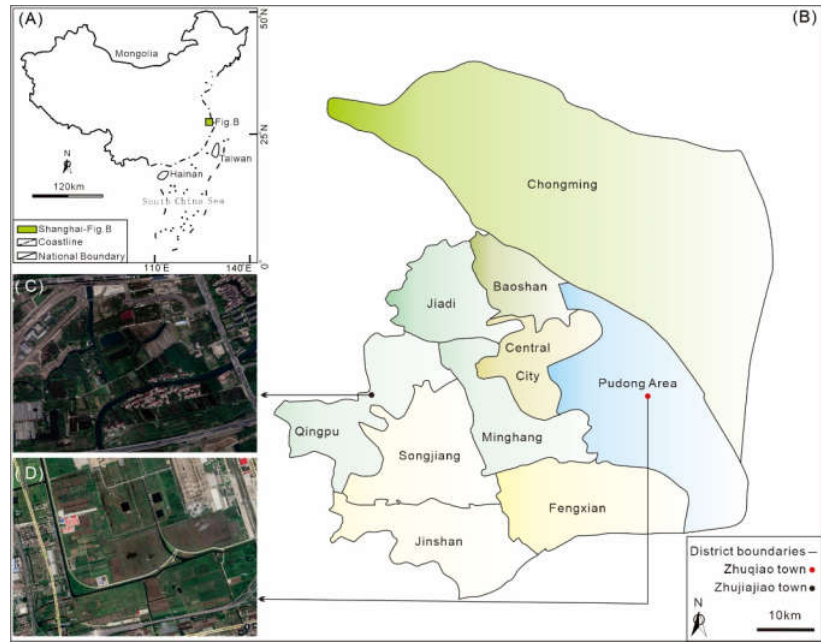
Figure 1. Study area. Notes: ( A ) shows the location of Shanghai in China; ( B ) is the administrative division of Shanghai; ( C ) and ( D ) are satellite maps of Zhuqiao Town and Zhujiajiao Town, respectively (from Google Earth).